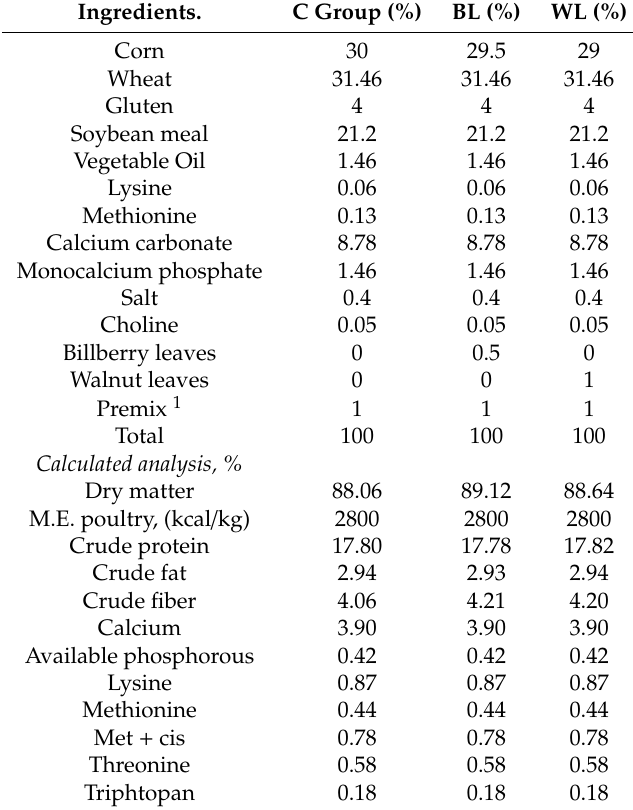
Table 1. Composition and chemical analyses of the basal diets.